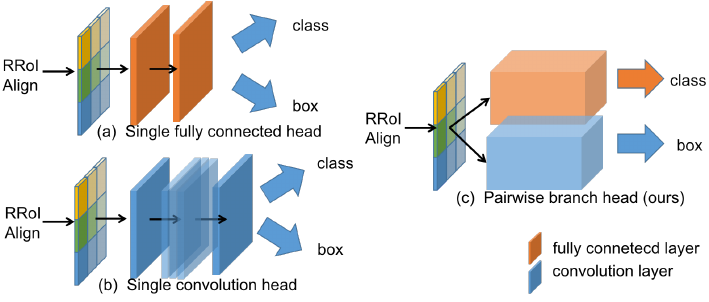
Figure 6. Structure of different detection heads.